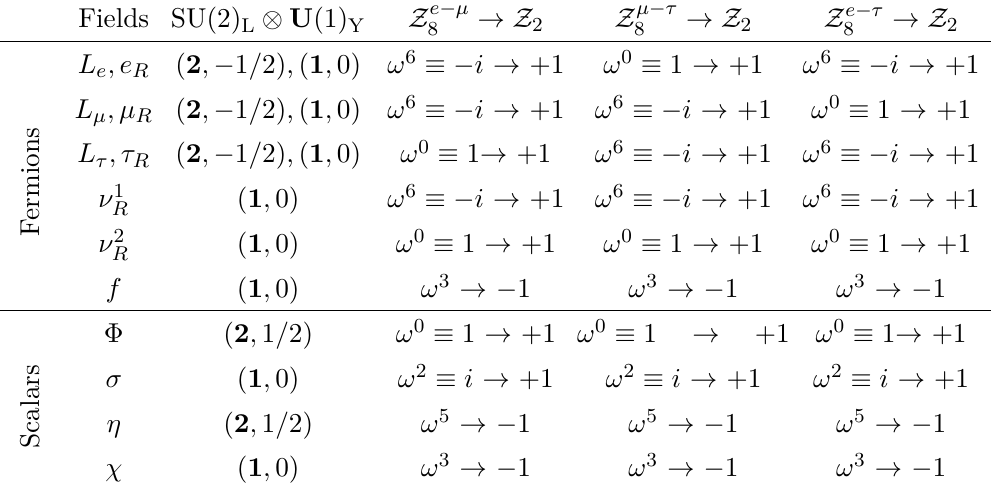
Table 1 . Matter content and charge assignments of the model. Here ω a = e 2 iπa/ 8 is the a -th power of the eighth root of unity that defines the Z 8